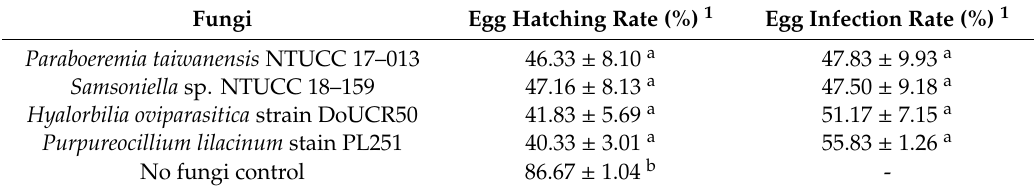
Figure 1. Observation of M. enterolobii eggs infected by nematophagous fungi, through a dissecting microscope. Bar = 45 μm . ( a ) Paraboeremia taiwanensis, ( b ) Samsoniella sp. strain NTUCC 18–159, ( c ) Hyalorbilia oviparasitica DoUCR50, ( d ) Purpureocillium lilacinum PL251. Table 1. E ff ects of the nematophagous fungi on M. enterolobii egg hatching and infection rate.